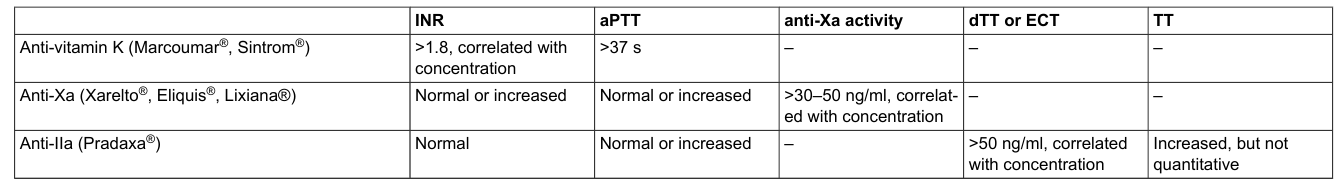
Table 3: Laboratory results indicating the presence of an anticoagulant effect according to laboratory results and type of anticoagulation.